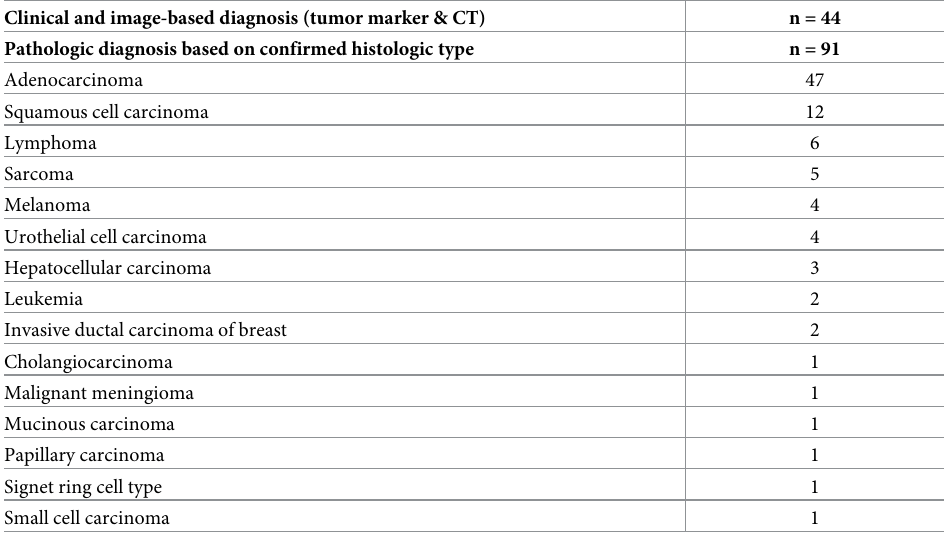
Table 2. Diagnosis of 135 cancer patients based on clinical and histologic type with available pathologic results. Clinical and image-based diagnosis (tumor marker & CT)